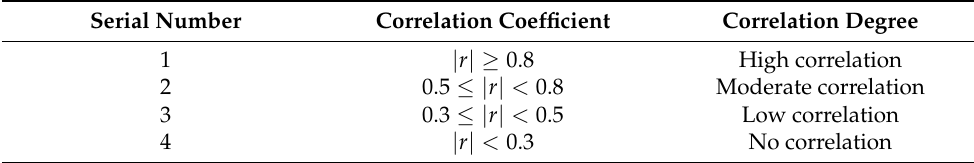
Table 1. The classification table of correlation